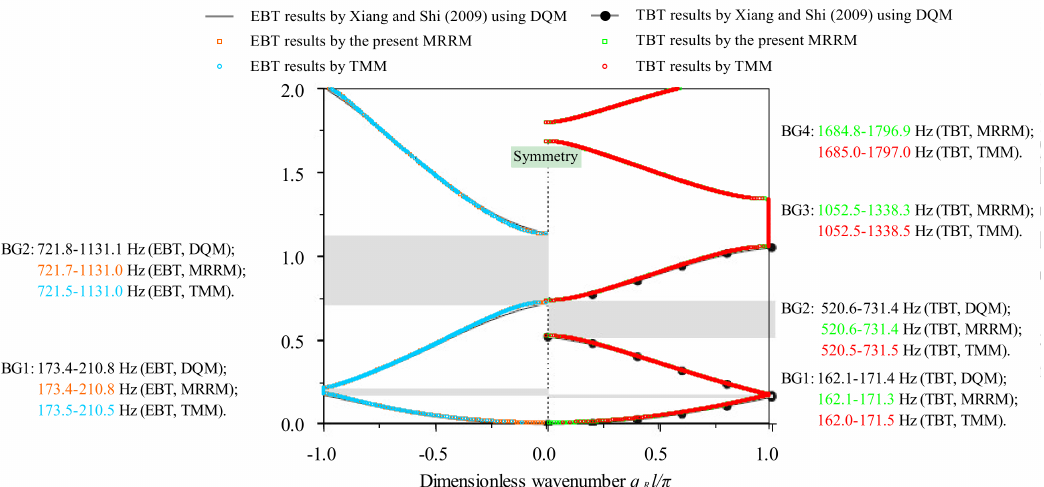
Figure 3. The first several phase constant spectra and the boundary frequencies of band gaps of characteristic bending waves in the bi-coupled periodic beam with Binary-I unit cell. EBT: